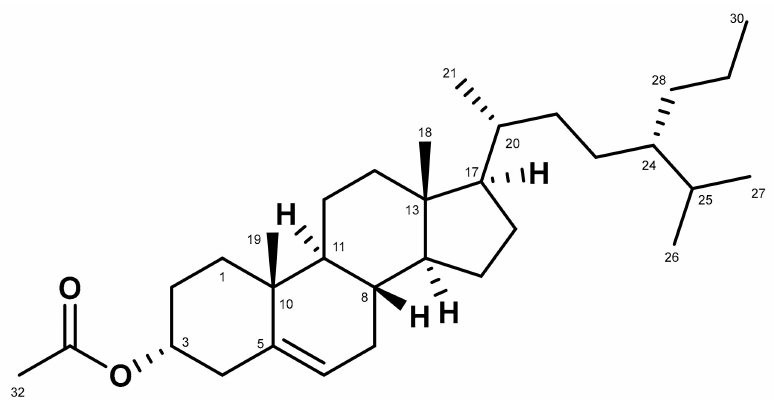
Figure 1. Chemical Structure of Compound 1